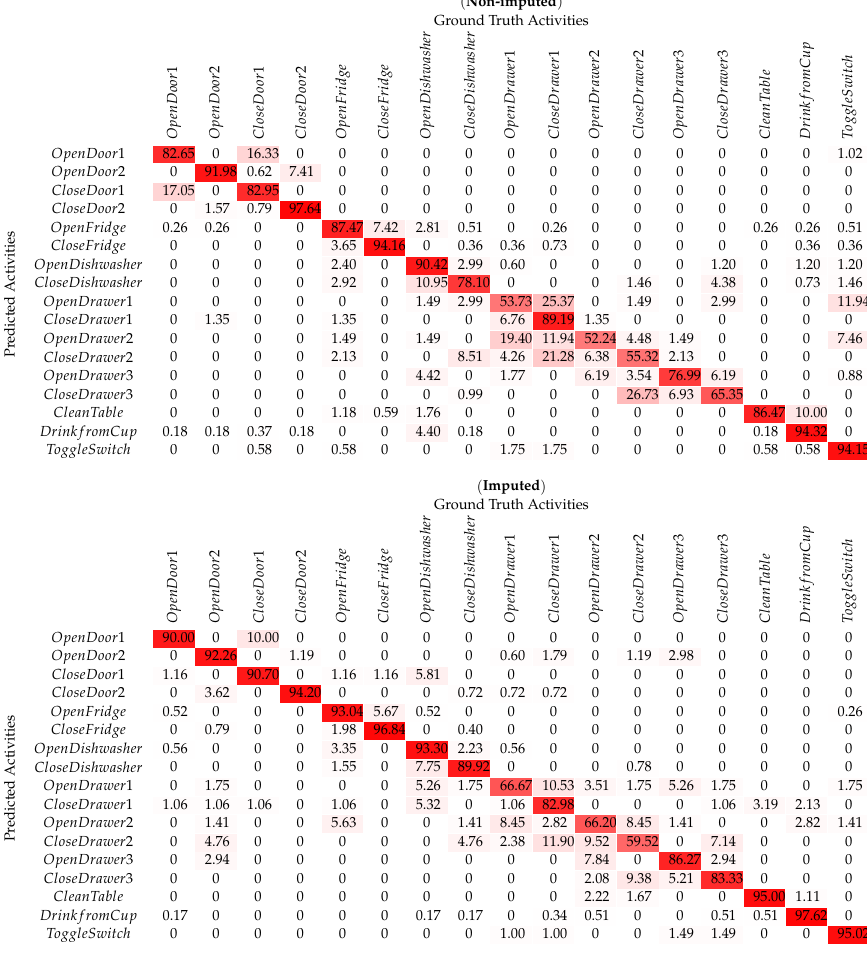
( Non-imputed ) GroundTruthActivities